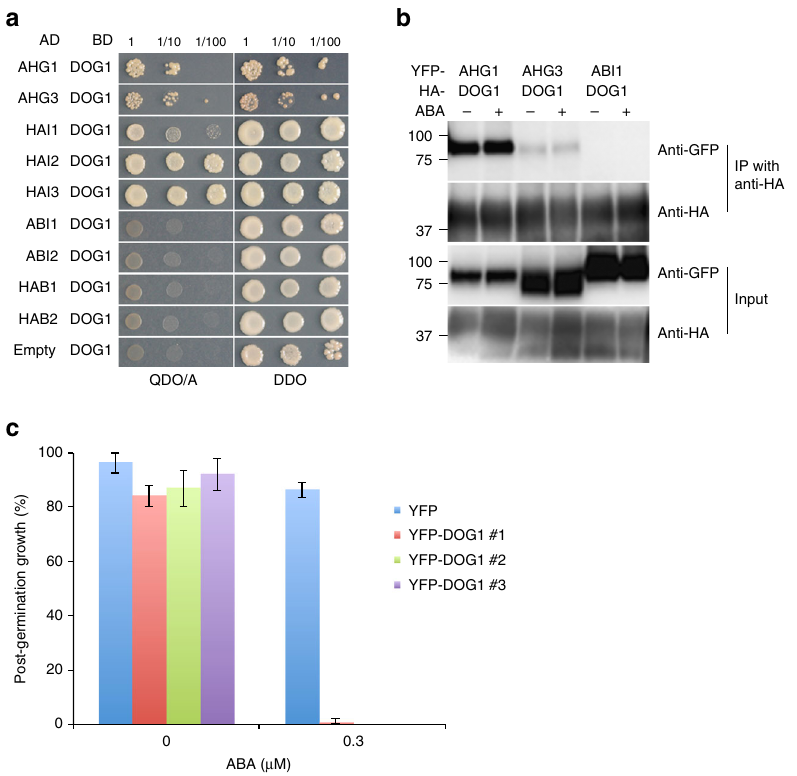
Fig. 4 Physical interaction of AHG1 with DOG1. a Yeast two-hybrid analysis of group A PP2Cs with DOG1. Y2H gold cells transformed with GAL4BD-DOG1 and GAL4AD-PP2Cs, as indicated, and were spotted onto DDO (Double dropout medium: SD/-Leu/-Trp) and QDO/A (Quadruple dropout medium: SD/- Ade/-His/-Leu/-Trp supplemented with Aureobasidin A) medium agar plates for 7 days after inoculation. b Interaction of DOG1 with AHG1, AHG3, and ABI1. HA-DOG1 co-immunoprecipitates with YFP-AHG1 and YFP-AHG3, but not YFP-ABI1. Total protein extracts from transformed N. benthamiana leaves were harvested 4 days after inoculation and were treated with or without 100 μ M ABA for 24 h before harvesting. After co-immunoprecipitation using anti- HA matrix, the input and the immunoprecipitated samples were detected with anti-GFP and anti-HA antibodies. c Post-germination growth ef fi ciencies of overexpressing YFP-DOG1 and control YFP lines were treated with or without 0.3 μ M ABA at 7 days after strati fi cation. Error bars show s.d. of three independent experiments using the same seed